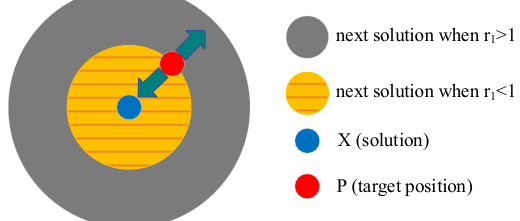
Figure 2. The effect of sine and cosine in Equation (1) on the next position [24]. To balance exploration and exploitation stages, Equation (2) is used as well. Here, a is constant, T is the maximum number of cycles, and t is the current cycle. Sine and cosine search different regions depending on whether they are greater or less than one. It returns when it takes values between −1 and 1 close to the objective function [24].